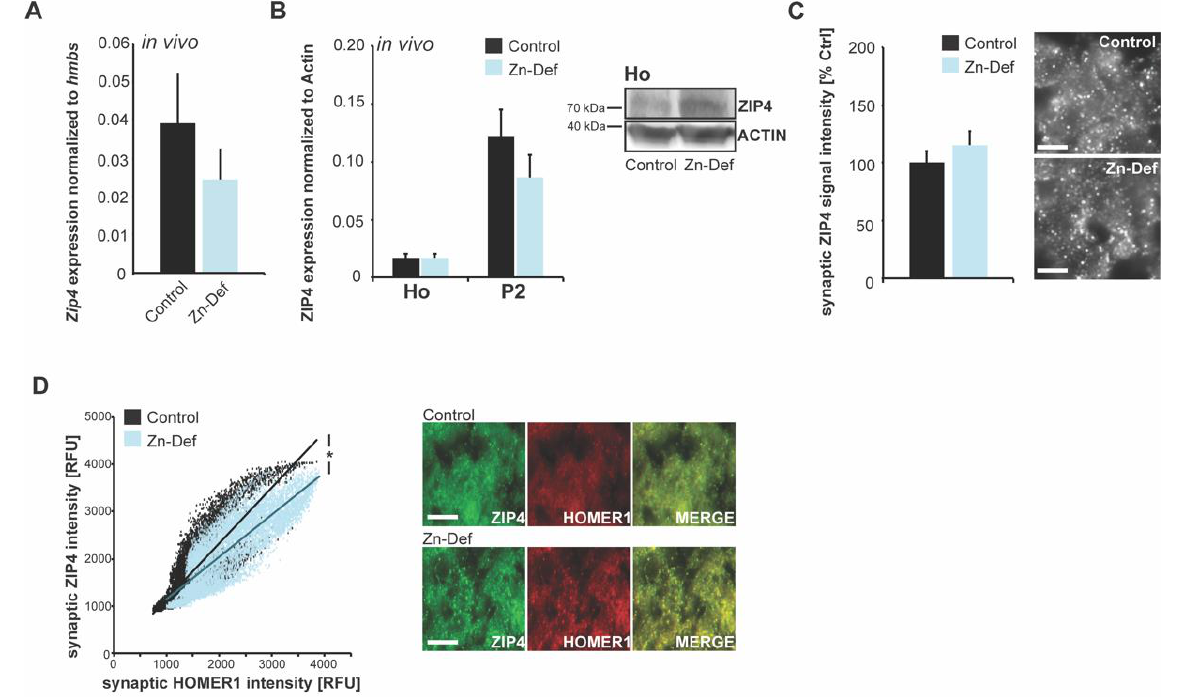
Figure 3. Only synaptic ZIP4 expression is sensitive to local zinc levels. ( A ) Expression of the Zip4 gene was detected in whole brain lysate of wild-type mice ( n = 3 mice) and acute zinc-deficient mice ( n = 3 mice) and normalized against hmbs . No significant difference was detected between control and zinc-deficient mice ( t -test). ( B ) Acute zinc-deficient mice also showed no significant change of ZIP4 on protein level in whole-brain homogenate and P2 fractions compared to controls ( n = 3 per group). ( C ) No significant change of ZIP4 on protein level was detected using immunohistochemistry. The average signal intensity of ZIP4-positive puncta was measured in the cerebellum of control and acute zinc-deficient mice (t-test, n = 3 mice per group) (scale bar = 5 μm). ( D ) A co-staining of HOMER1b/c was performed and the ZIP4 signal intensity at HOMER1b/c-positive puncta correlated with HOMER1b/c signal intensity in the cerebellum of mice. Acute zinc-deficient mice show a significant reduction of ZIP4 signal intensity that positively correlates with HOMER1b/c signal intensity (R-values were obtained with the Spearman correlation r Ctrl = 0.774; p Ctrl < 0.0001; r Zn-def = 0.844; p Zn-def < 0.0001). Fisher-Z transformation reveals a significant loss at puncta with higher HOMER1b/c signal intensities (z Ctrl = 1.030; z Ctrl = 1.235; σ = 0.014; Z = 14.402 with no overlap of the 95%— confidence intervals, n = 3 mice per group) (scale bar = 10 μm).